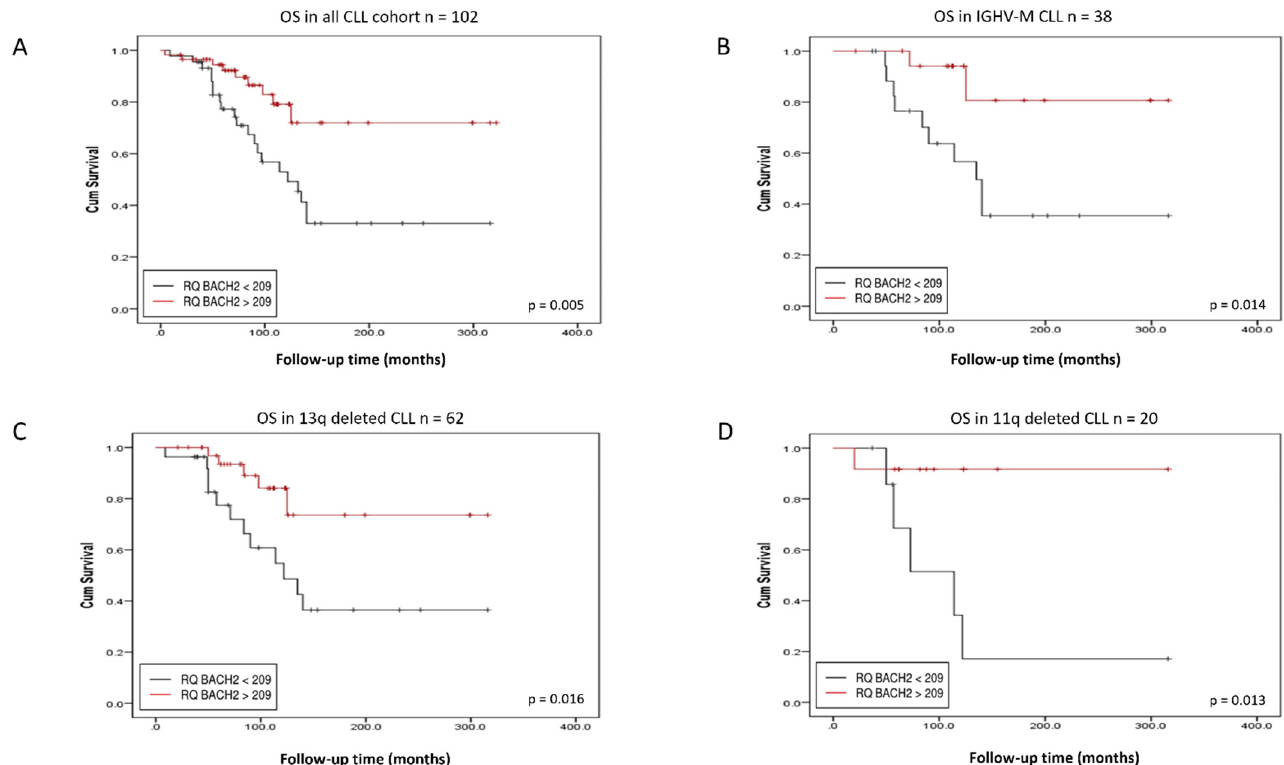
Figure 2. Kaplan–Meier analysis of CLL patients stratified by BACH2 RNA expression. BACH2 low expression predicts shorter overall survival in the whole cohort ( A ), in immunoglobulin heavy chain variable region-mutated (IGHV-M) patients ( B ), in 13q-deleted patients ( C ) and in 11q-deleted subgroups ( D ).